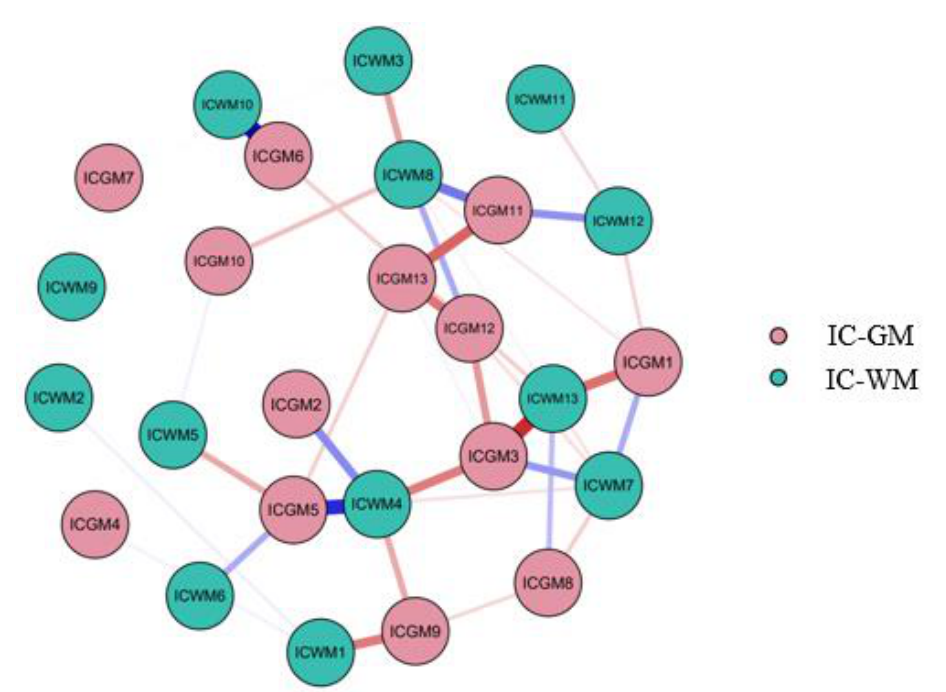
Figure 4. Network Analysis. Network plot of all components. Positive relationships are represented in blue, negative relationship are represented in red. Table 3. Centrality measures for all the components in the network analysis.